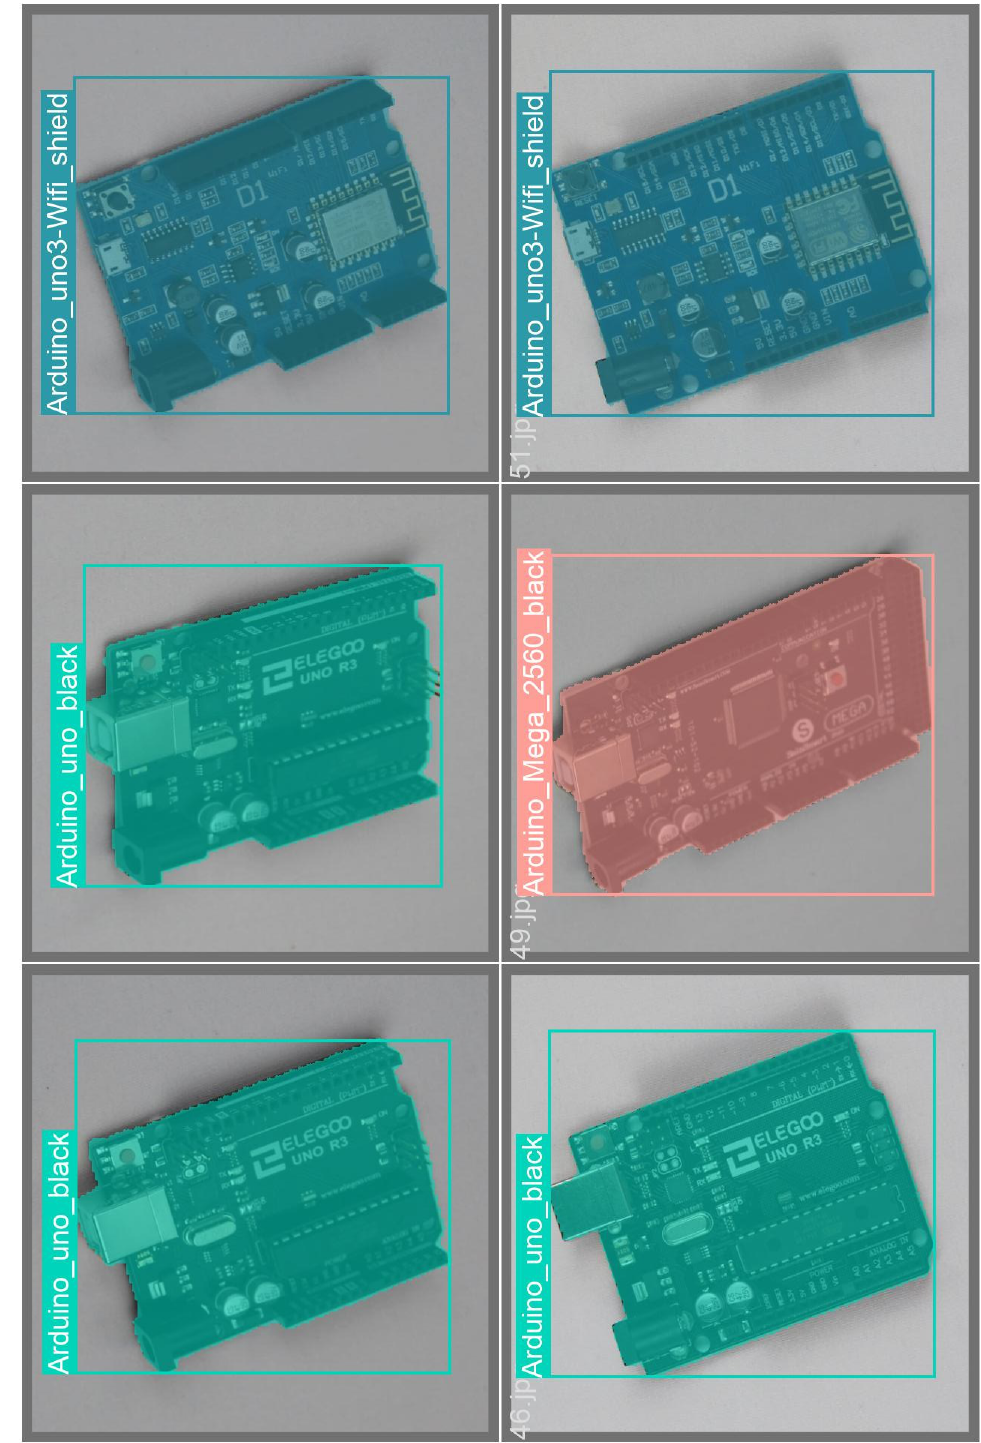
Figure A1. First validation of data marked with